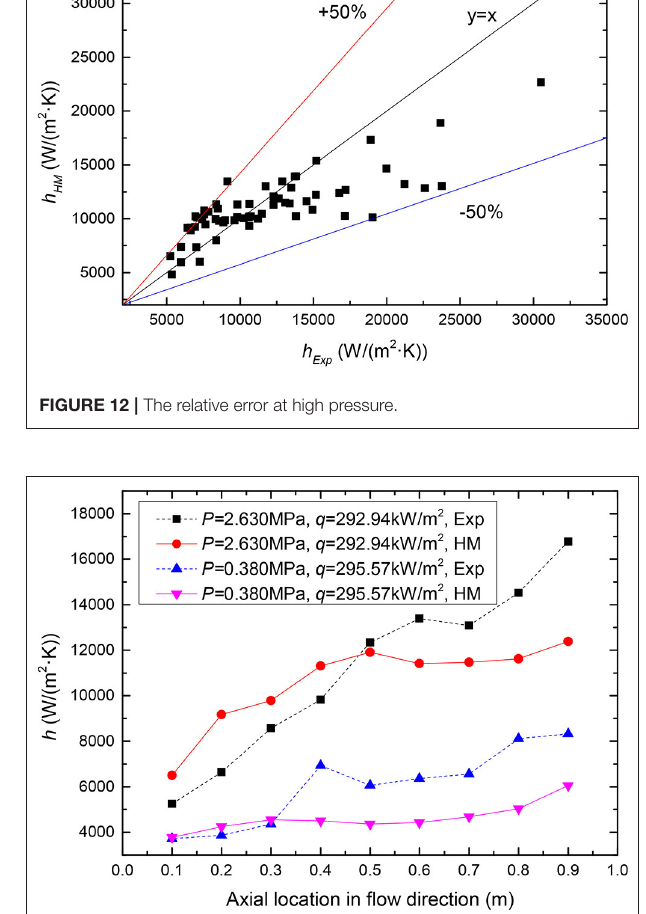
indicates the relative error at high pressure. The relative error between simulation and experiment is from − 50 to +